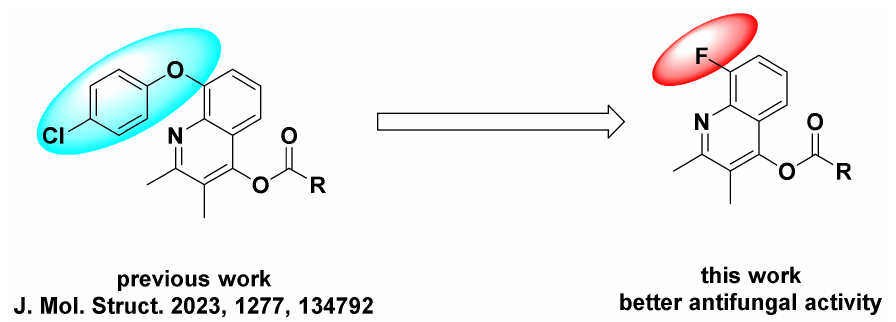
Figure 1. Some commercialized pesticides or drugs with fluorinated quinoline derivatives.